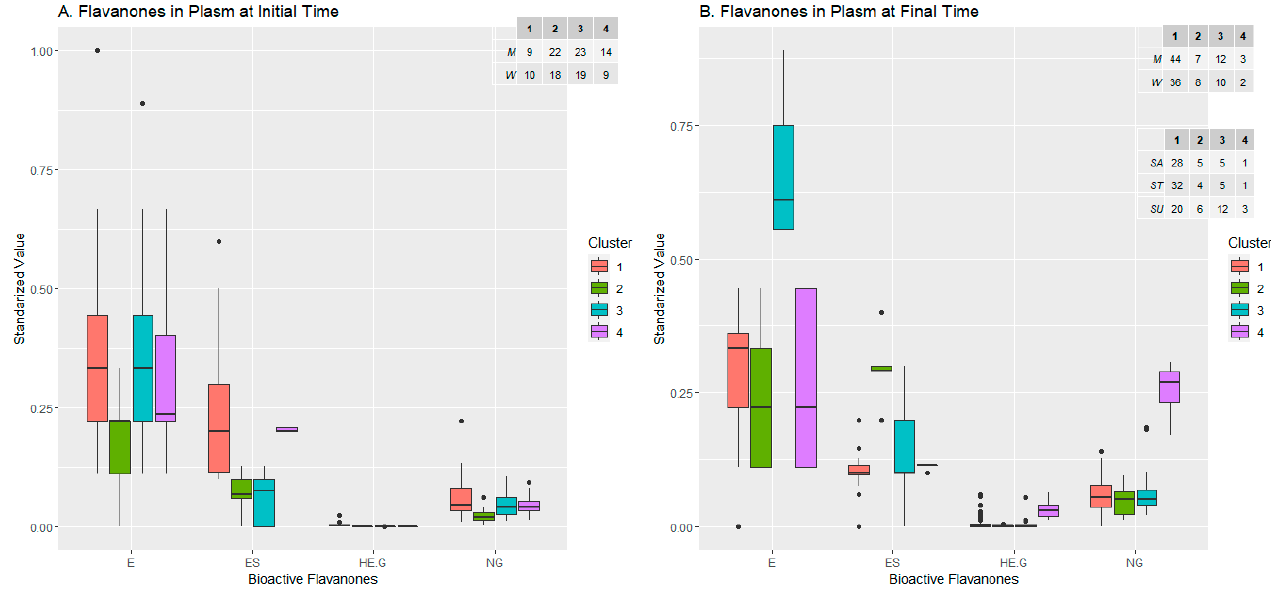
Figure 6. Levels of bioactive flavanones molecules within the groups generated by clustering analysis before ( A ) and after ( B ) beverage consumption, and composition of groups in terms of the sexes and sweeteners added to the drink.